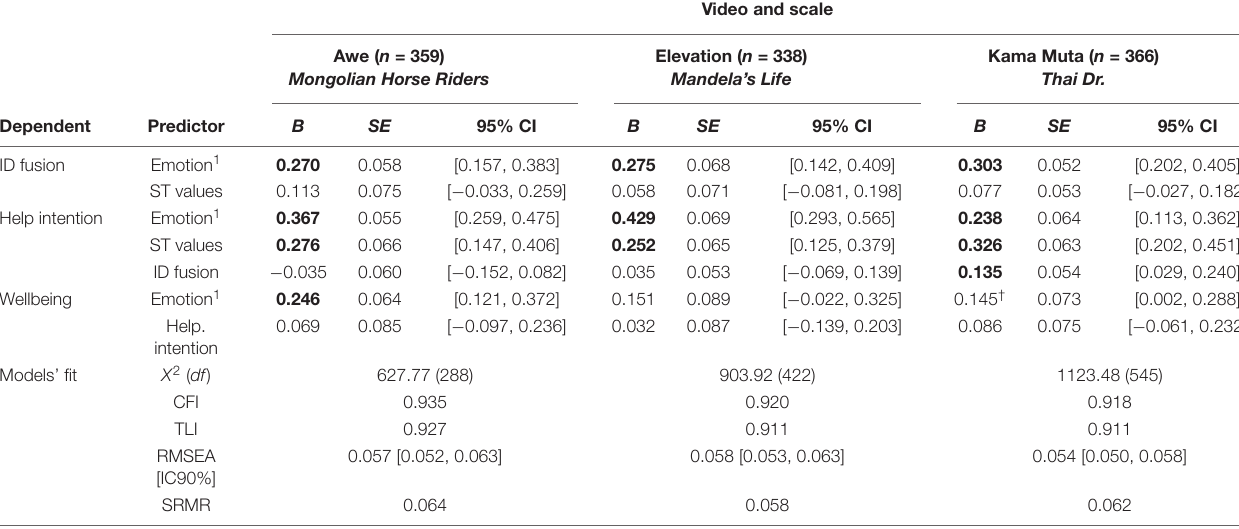
TABLE 7 | SEM analyses predicting ID fusion with humanity, help intention to others, and individuals